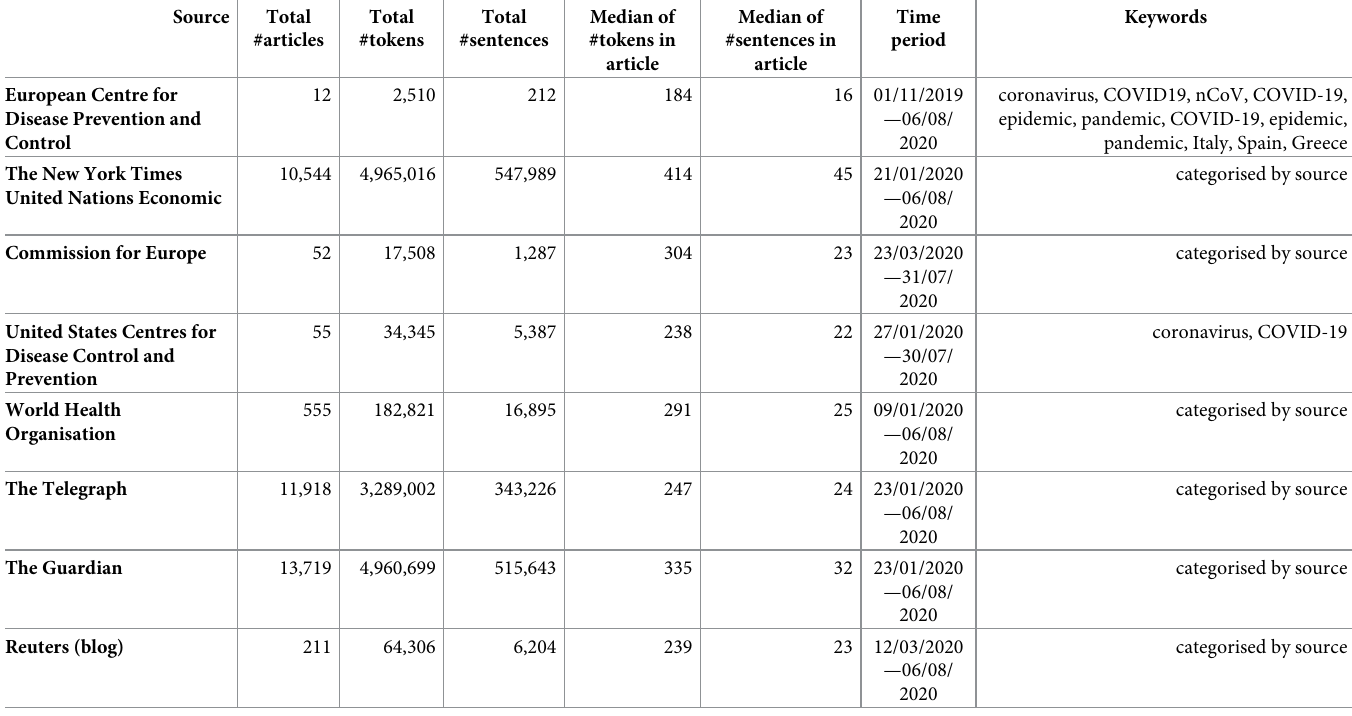
Table 1. Details on collected articles (after